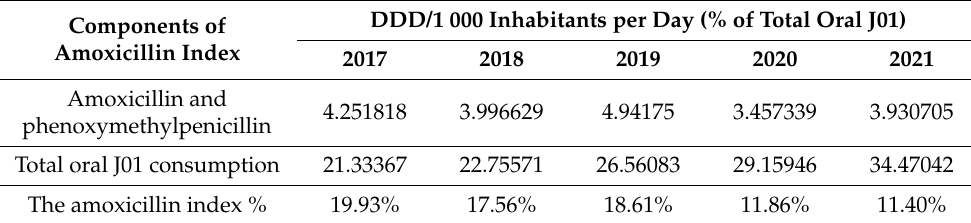
Table 2. Changes in quality indicator—amoxicillin index in Serbia from 2017 to